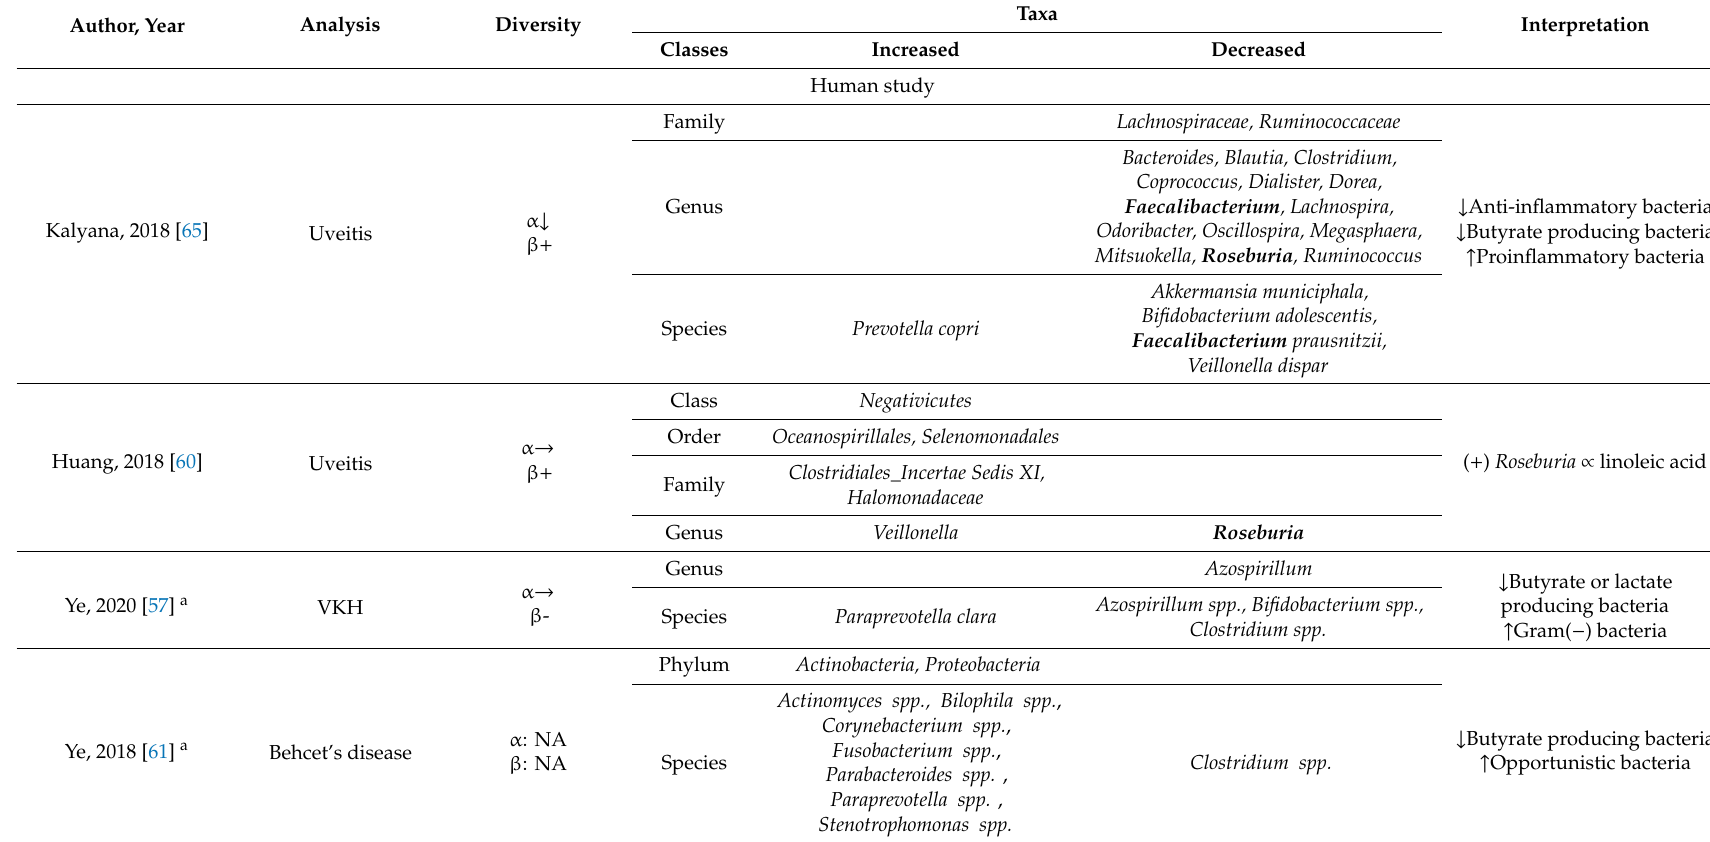
Table 2. Representative gut dysbiosis in various ocular diseases of the human and